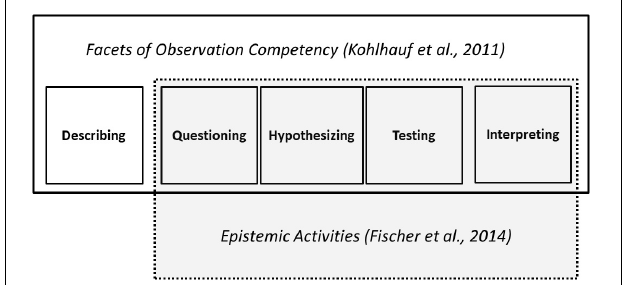
FIGURE 1 | Facets of observation competency and their relation to epistemic